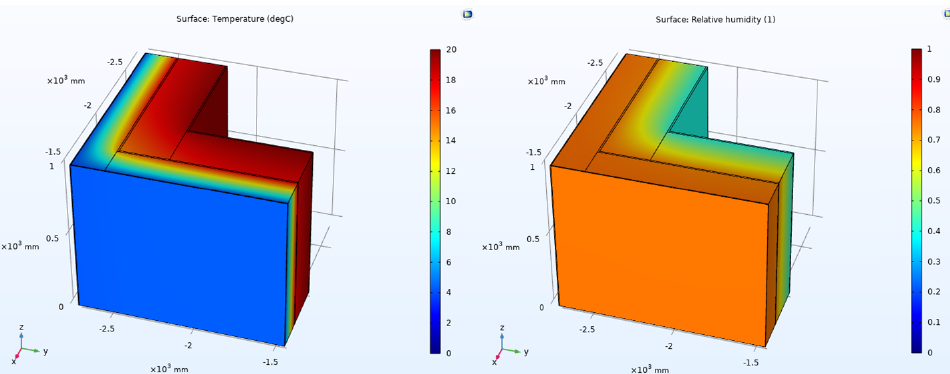
Figure 6. Temperature distribution (left) and relative humidity distribution (right) from HAM simulation based on BIM